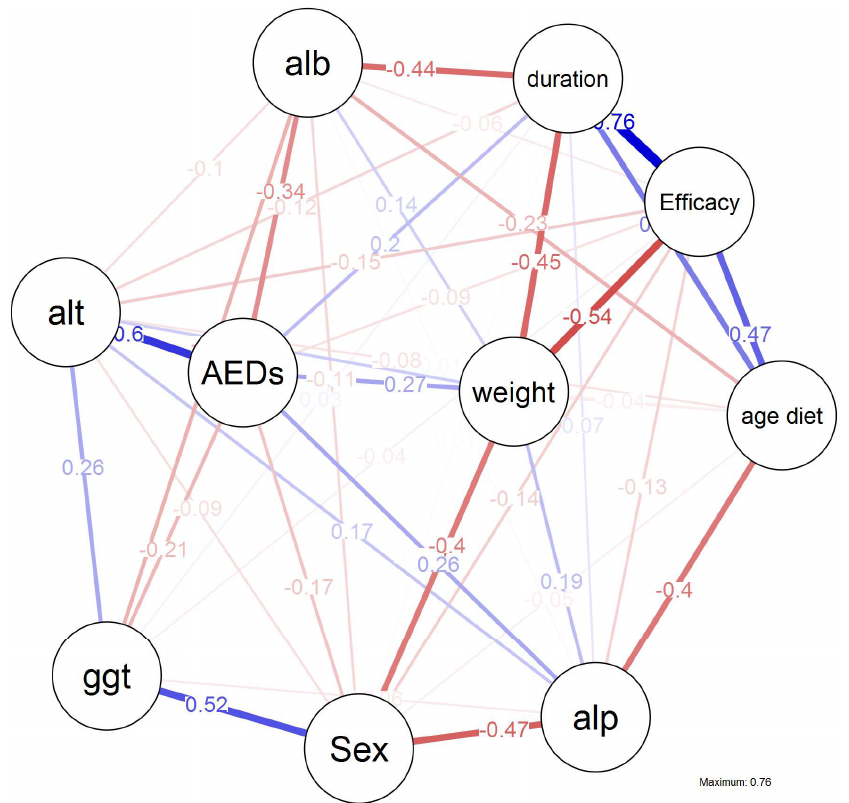
Figure 3. Partial weighted correlations network analysis between ketogenic diet efficacy and differ- ent